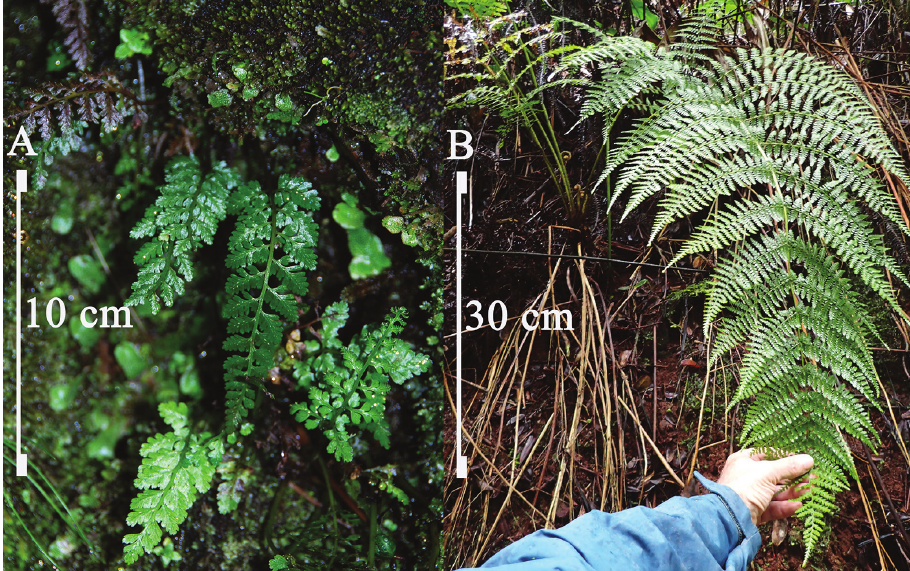
Figure 4. A Mature plants of Athyrium haleakalae , showing habitat preference along concave hollow of stream, Hana Forest Reserve, East Maui, HI (22 Aug 2013, Wood & Oppenheimer 15639 ) B Mature plant of Athyrium microphyllum , showing terrestrial habitat preference, erect rhizome, and large size, Mohihi, Kaua‘i, HI (18 Dec 2014, Wood & Flynn et al. 16175 ). Photos by K.R.